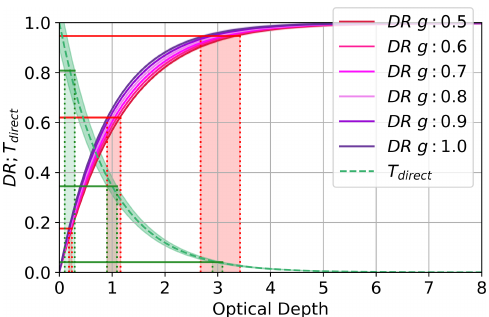
Figure 2. Solutions given the direct transmittance using Beer’s law (Eq. 1) and the diffuse ratio (Eq. 3) for given layer optical depths. Shown are uncertainties in optical depth for irradiances associated with layer optical depths of 0.2, 1.0, and 3.0. Uncertainty in F dir is 7.0%, and uncertainty in DR is